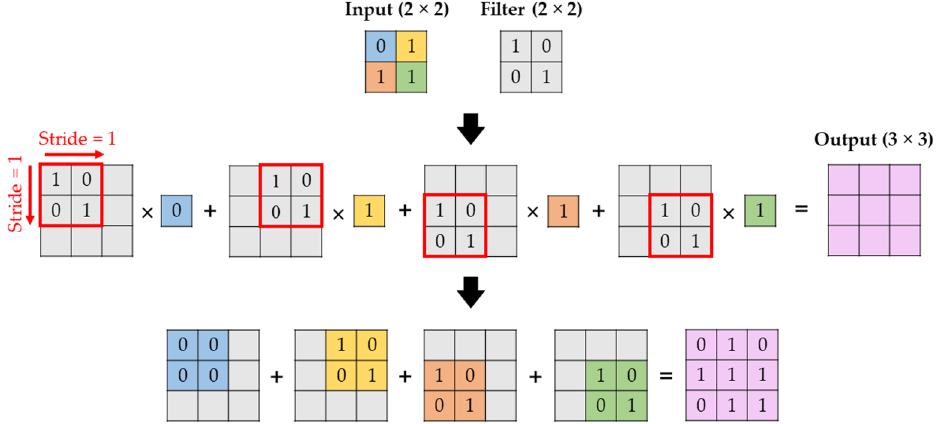
Figure 14. Transposed convolution.